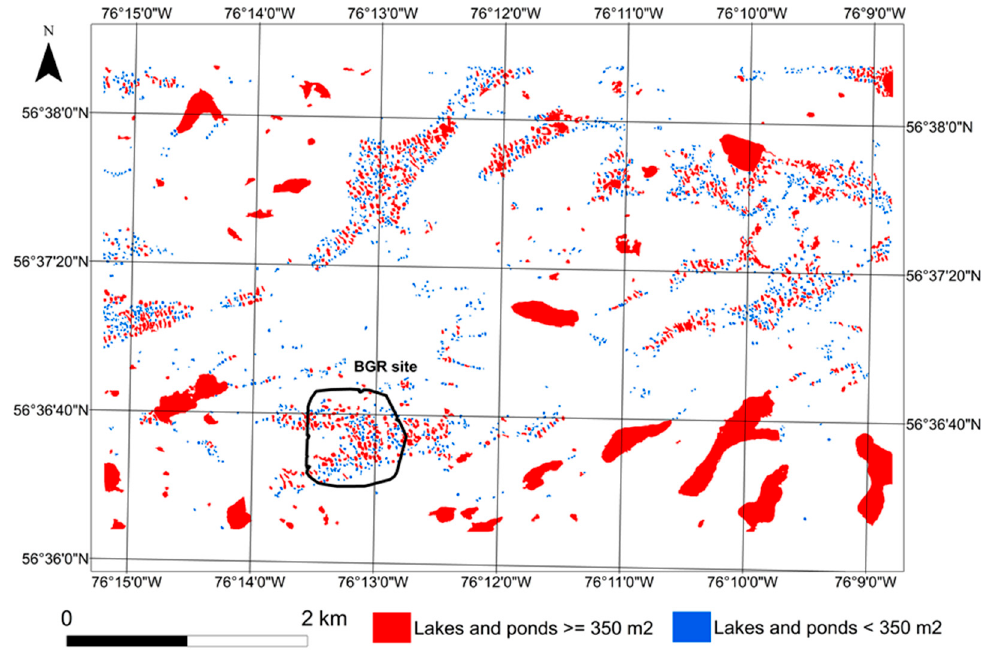
Figure 13. Lakes and ponds around the BGR site.